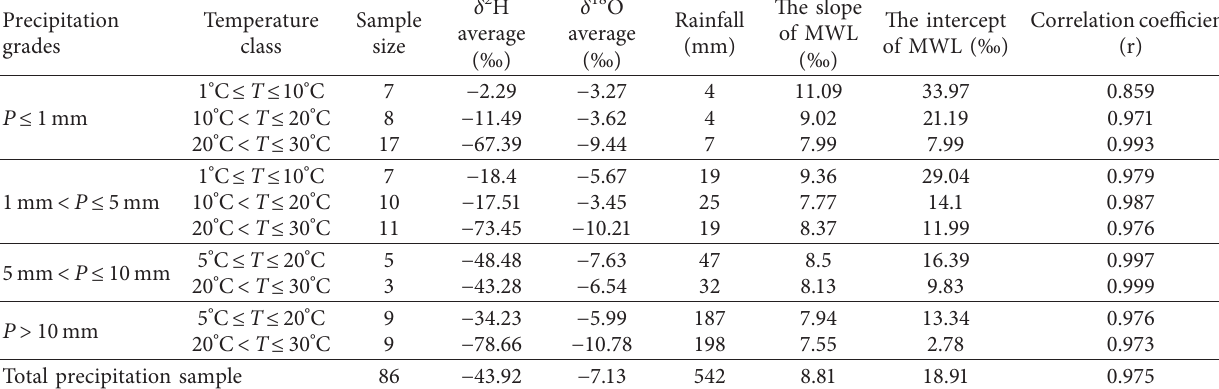
Table 2: The δ 2 H- δ 18 O correlation parameters for different precipitation levels in the Guanling region. Precipitation Temperature grades